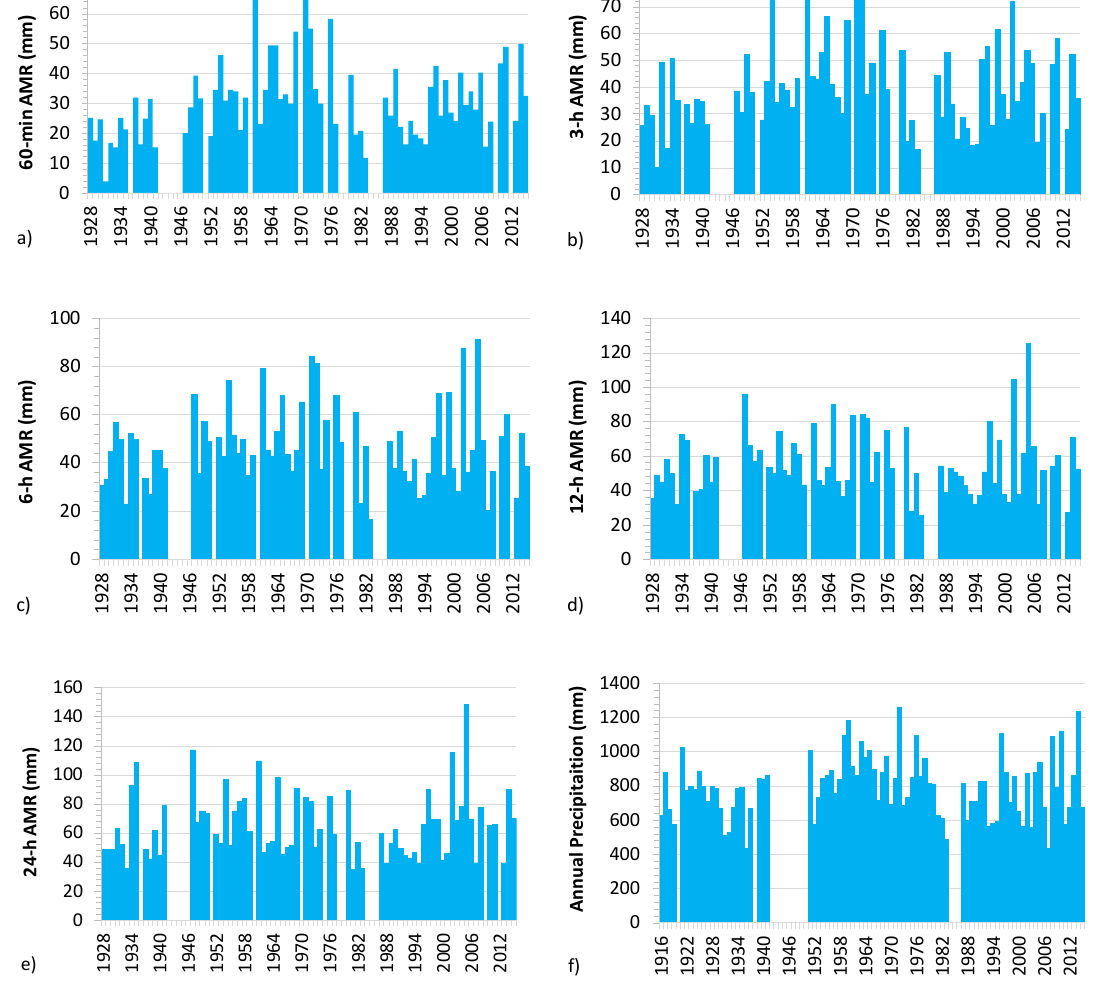
Figure 3. Viterbo rain gauge: chronological histograms for the investigated time series of Annual Maximum Rainfall (AMR) with durations from 1 to 24 h ( a – e ) and Annual Precipitation (AP) ( f ). The comparisons among average values for sample and NSRP AMR series (also including sub- hourly series, used for validation) and Annual Precipitation are reported in Table 3. Table 3. Viterbo rain gauge: sample and NSRP mean values for the investigated time series.